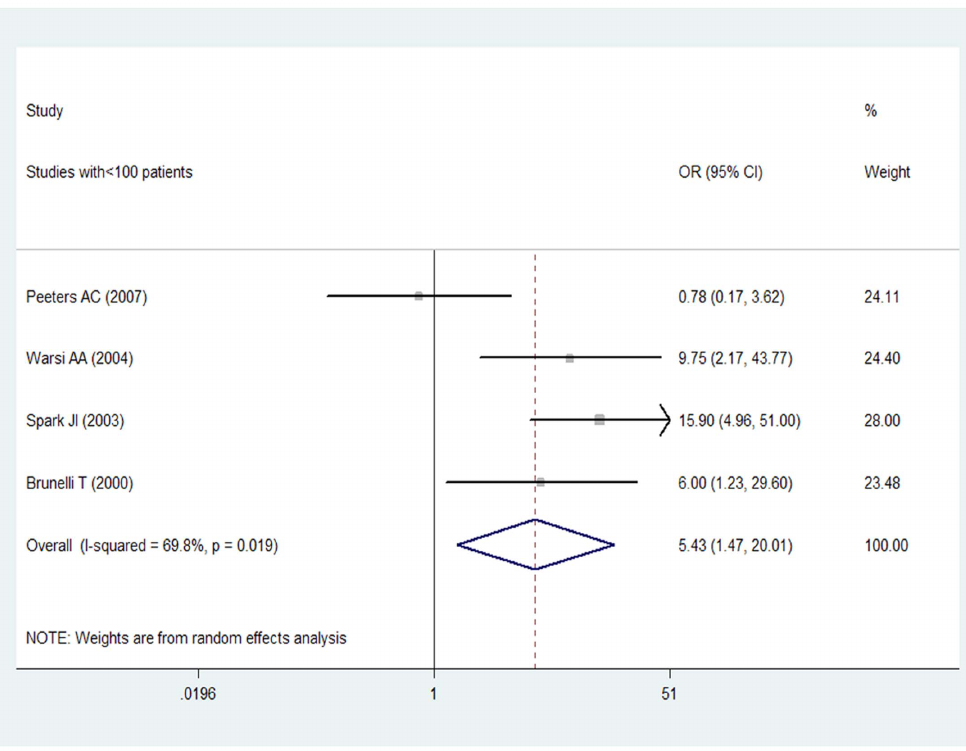
Figure 4. OR and 95% CI from the studies with , 100 patients of plasma Hcy level and AAA.